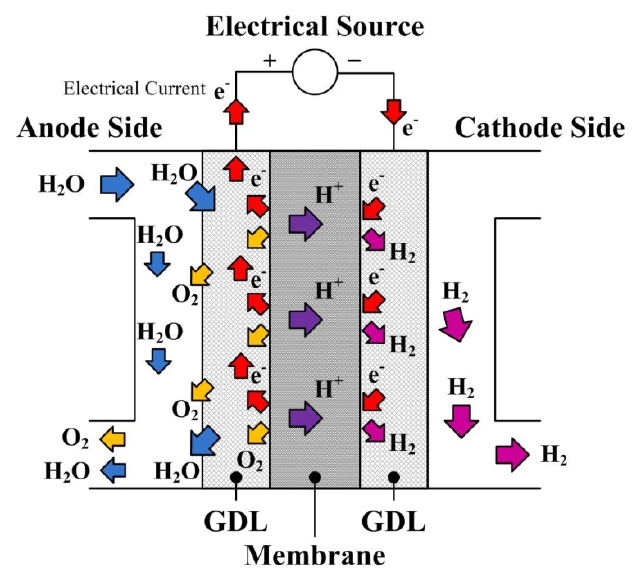
Figure 1. Principle of proton exchange membrane (PEM) electrolyzer.